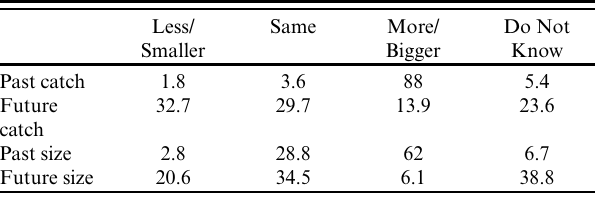
Table 3 . Fisher perceptions of past and future fish catch and